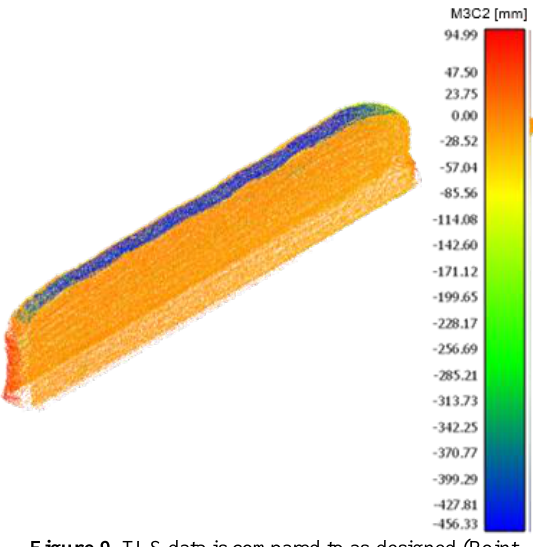
Figure 9 . TLS data is compared to as-designed (Point Cloud) by M3C2 algorithm after eliminating the outliers.